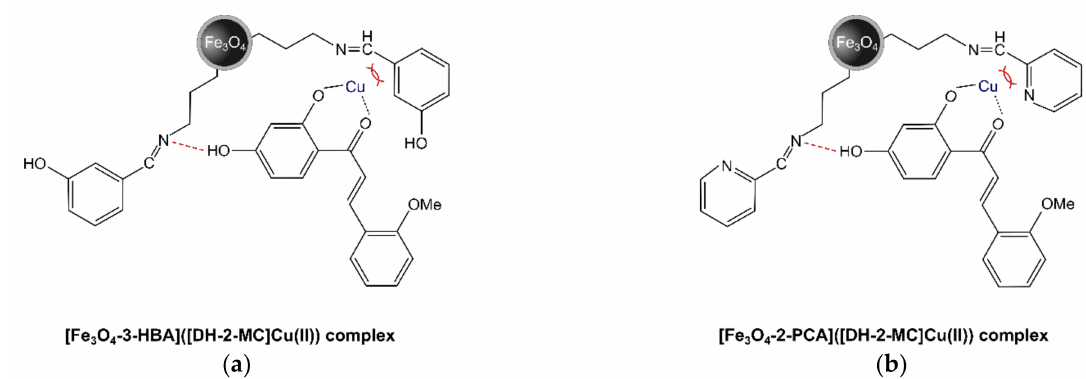
Figure 12. The proposed presentation of decreased interactions between the Cu(II)-complexed hybrid materials containing ( a ) 3-HBA or ( b ) 2-PCA as a pendant residue and DH-2-MC, triggered by a steric hindrance (red